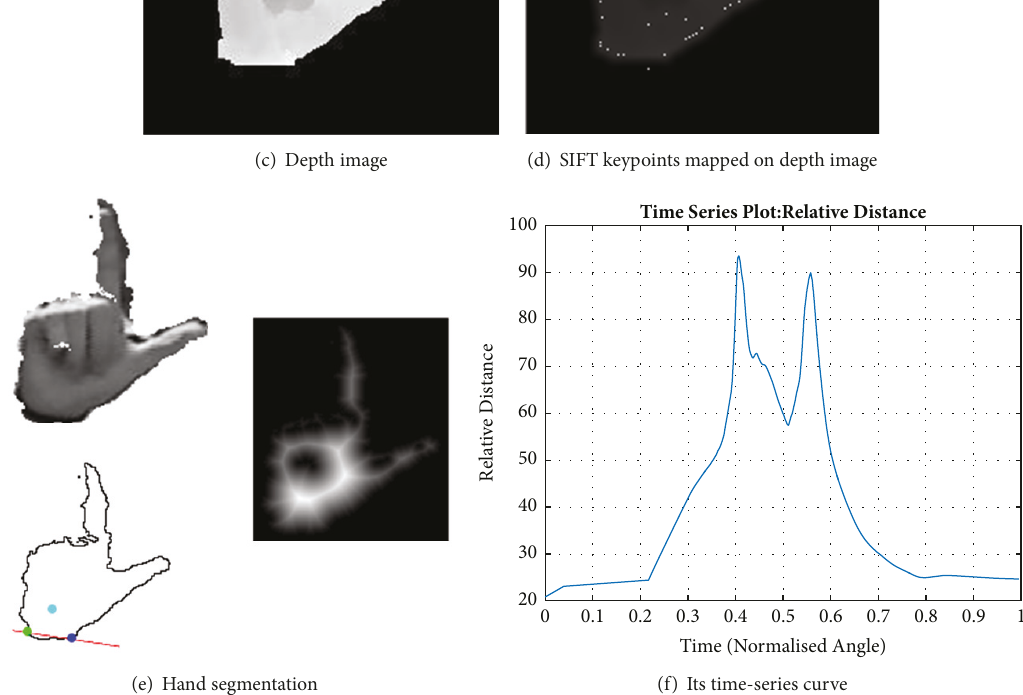
Figure1:DifferencesinthenumberofSIFTkeypointsinboth(a)binaryimageand(c)depthimageandtheuseoffingerbendinginformation.